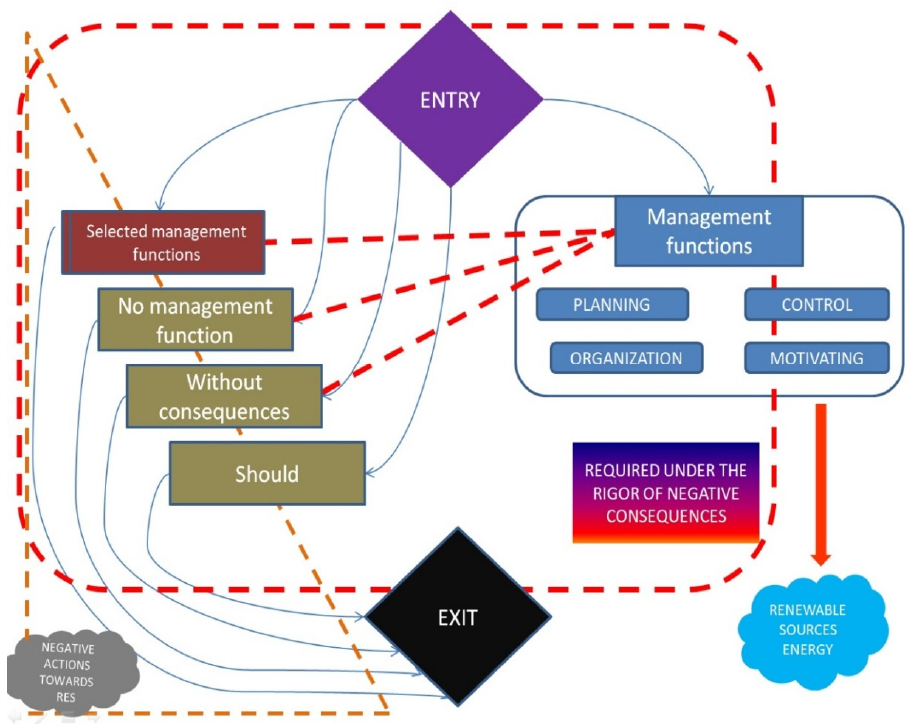
Figure 31. Descriptive model increasing the effectiveness of the assumed RES targets.